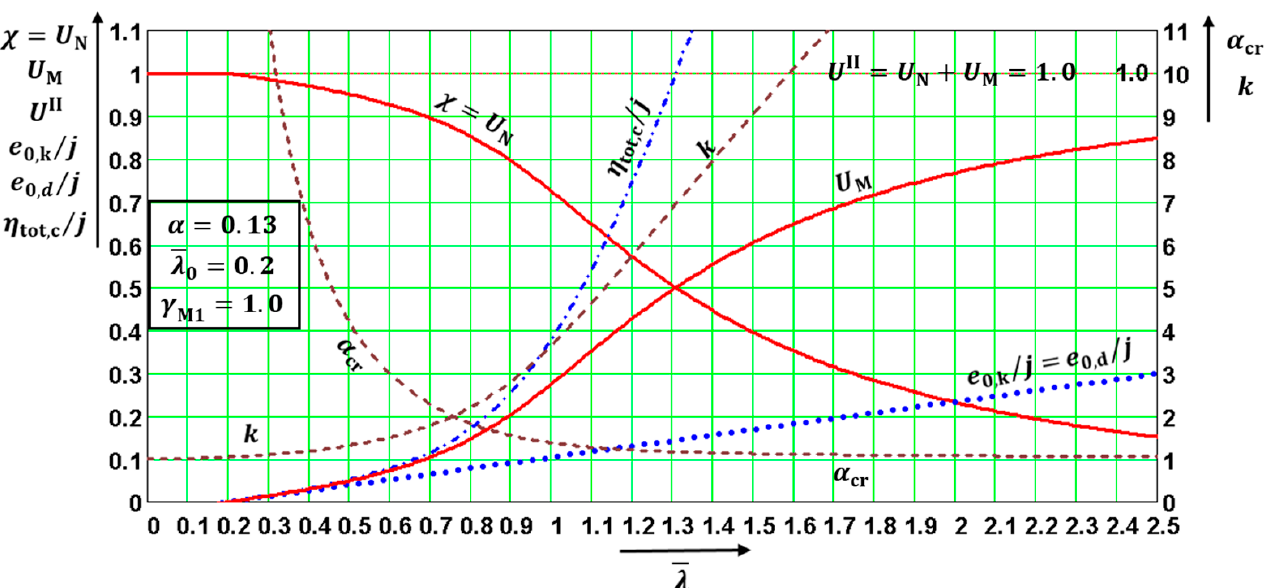
quantities α cr , k , and e 0,d / j are functions of safety factor γ M1